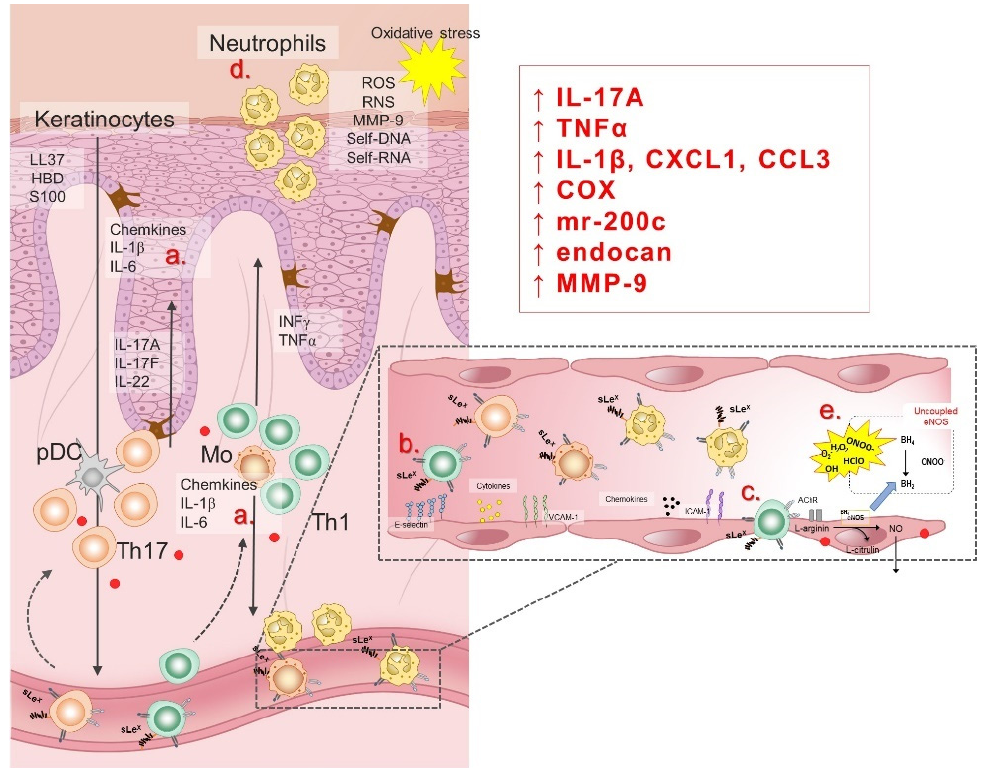
Figure 4. Pathogenesis of endothelial dysfunction in psoriasis patients is related to inflammation and oxidative stress. In response to the hypersaline microenvironment, keratinocytes and lymphocytes (a) secret pro-inflammatory cytokines (i.e., interleukin (IL)-1 β , IL-6, TNF α ) and chemokines, leading to endothelial activation characterized by the cell adhesion molecules (CAMs) upregulation (b). In response to the chemokines and interactions with CAMs, peripheral leukocytes transmigrate trough the vessel wall to the sites of inflammation (c). Neutrophils are predominant cell type in leukocyte infiltrate of the psoriatic skin, responsible for generation of reactive oxygen (ROS) and nitrogen (RNS) species (d). An additional mechanism of oxidative stress during increased dietary salt intake involves RAS suppression and eNOS uncoupling (e). LL37, cathelicidin antimicrobial peptide LL37; HBD, human beta defensin; S100, calcium-binding protein S100; IL, interleukin; ROS, reactive oxygen species; RNS, reactive nitrogen species; MMP-9, matrix metalloproteinase 9; self- DNA, self-deoxyribonucleic acid; self-RNA, self-ribonucleic acid; IFN- γ , interferon γ ; TNF- α , tumor necrosis factor α ; pDC, plasmacytoid dendritic cell; Th17, T helper 17 cells; Th1, T helper 1 cells; sLe x , Sialyl Lewis X; CXCL1, C-X-C motif chemokine ligand 1; CCL3, C-C motif chemokine ligand 3; COX, cyclooxygenase; mr-200c, microRNA-200c; endocan, endothelial cell specific molecule-1; ICAM-1, intercellular adhesion molecule 1; VCAM-1, vascular cell adhesion molecule 1; AChR, acetylcholine receptor; eNOS, endothelial nitric oxide synthase; NO, nitric oxide; BH4, tetrahydrobiopterin; ONOO, peroxynitrite; H 2 O 2 , hydrogen peroxide; O 2 − , superoxide; OH, hydroxide; HClO, hypochlorous acid.